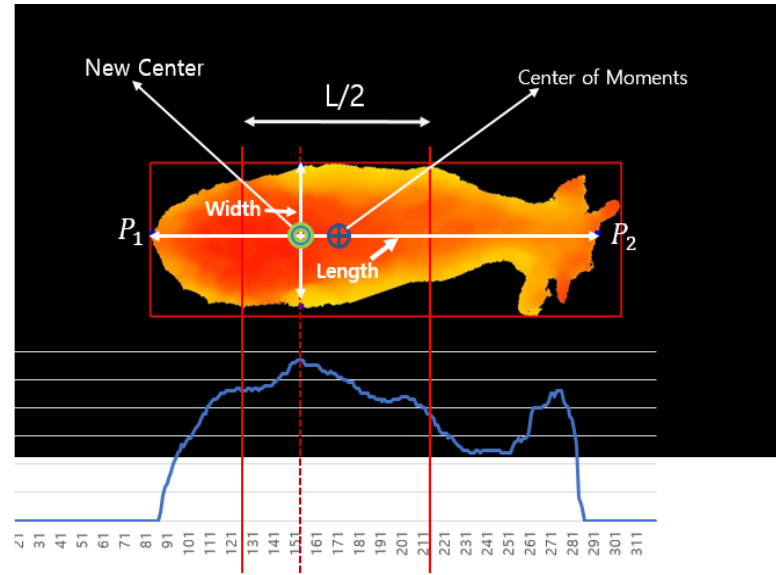
Figure 9. Process of calculating the length and width of Korean cattle.